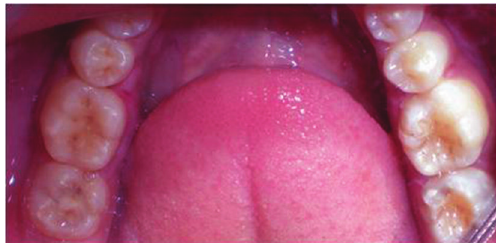
Figure 26: Occlusal view of the mandibular arch at 6-month recall shows satisfactory healing.